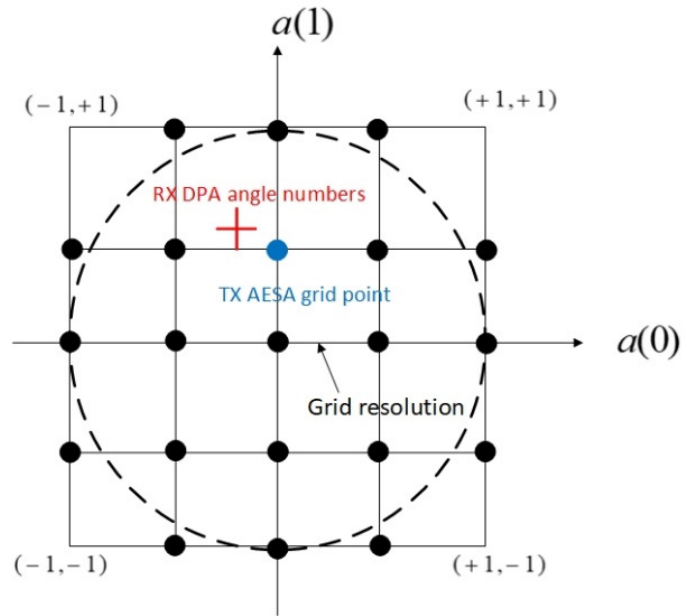
Figure 3. An example of the TX AESA angle number quantization grid. The grid resolution is defined as the distance between two nearest neighbors in the grid. An initial angle number pair or a RX DPA estimated angle number pair for the target is quantized to the nearest grid point. Note that the true target angle numbers satisfy 𝑎(0) (cid:2870) + 𝑎(1) (cid:2870) < 1 .